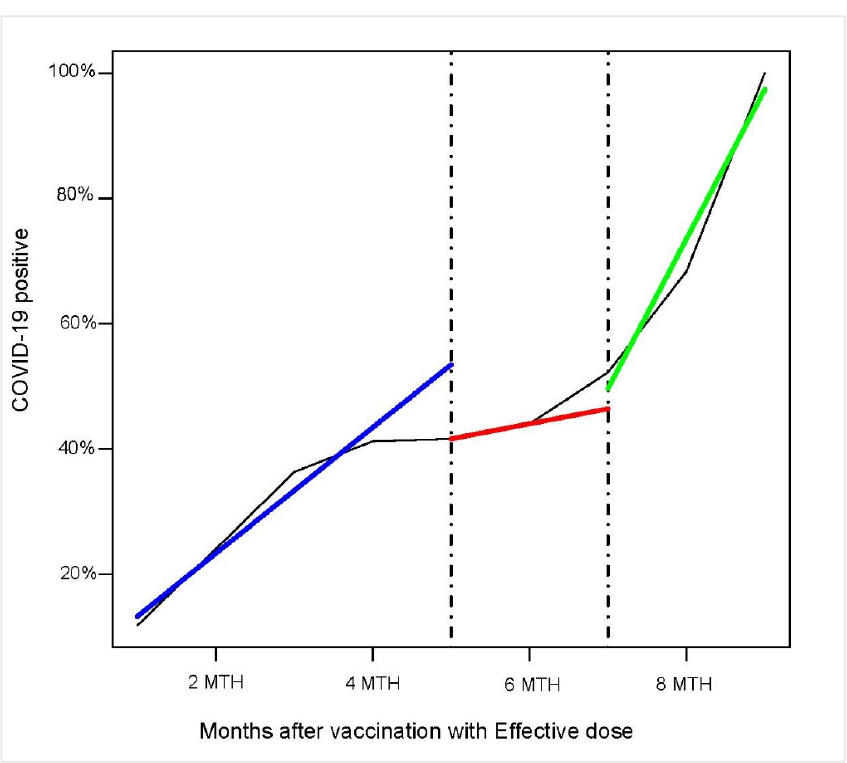
Figure 2. Segmented linear regression models. Notes: Segmented linear regression model and breakpoint estimates determined vaccination coverage in subjects who received effective vaccination and changes in trend over time. Changes in the slope segment indicated an impact of vaccination coverage on protection against COVID-19 infection.